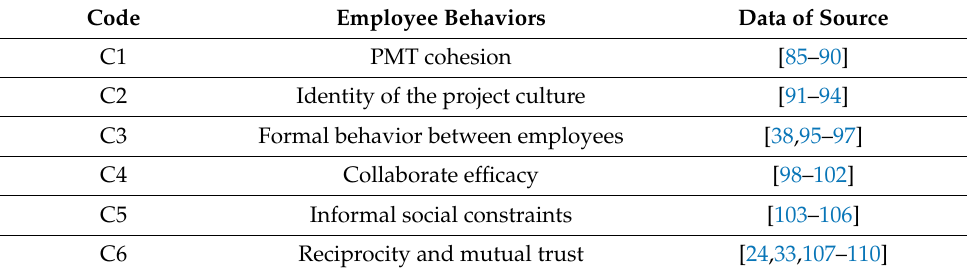
Table 1. Extracted employee behaviors and the data of